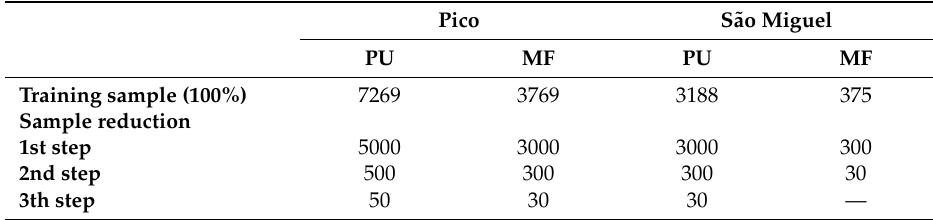
Table 1. Number of species records used in modeling, per island and species. PU: Pittosporum undulatum ; MF: Morella faya .